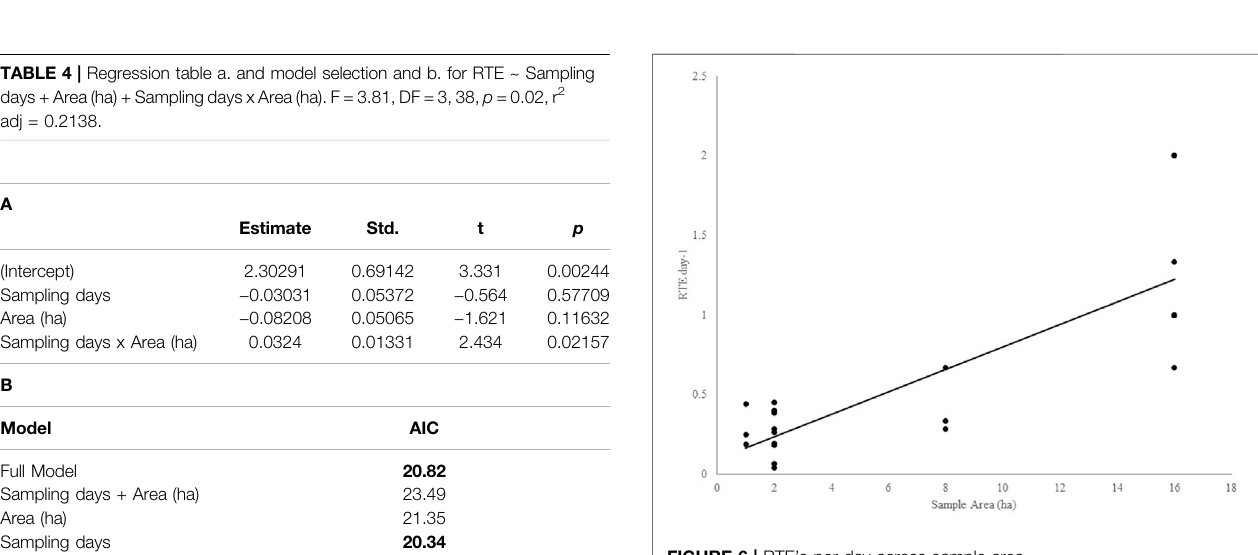
FIGURE 5 | Average (per day) detection of (A) . RTE ’ s (Kruskal Wallis chi-squared = 16.9, DF = 3, p = 0.0007); and (B) number of total RTE ’ s by method (Kruskal Wallis chi-squared = 17.9, DF = 3, p = 0.0005). Error bars represent 95% con fi dence intervals. Pairwise comparisons of methods indicated signi fi cant differences between bird banding and point counts (A and B) and between bird banding and autonomous recording units (B) .